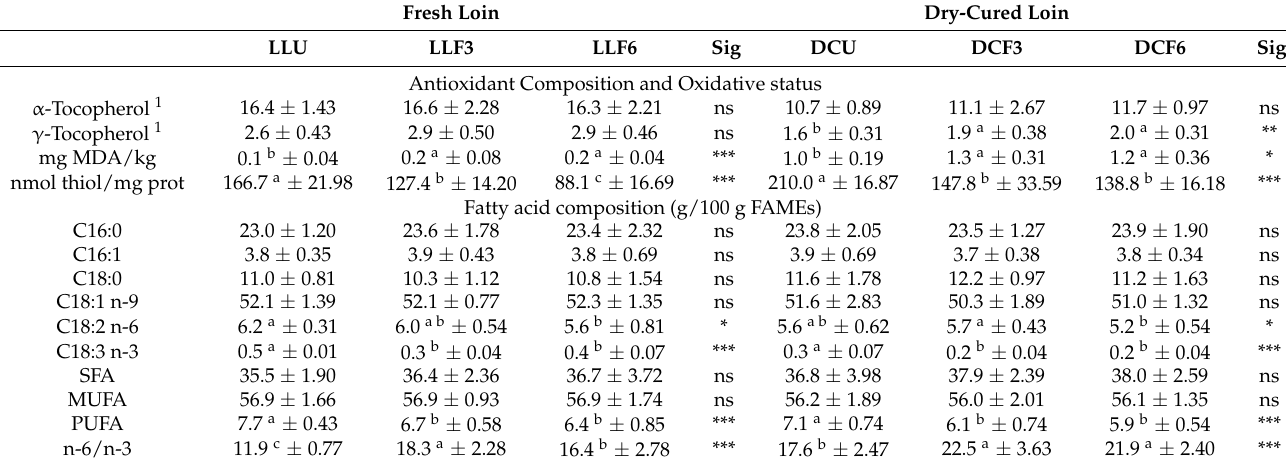
Values are expressed as means ± standard error of 15 samples/treatment. 1 Expressed as µ g of α - or γ -tocopherol/g moisture-free tissue. Effect: freezing time on LLU, LLF3 and LLF6 = unfrozen, and frozen during three- or six-months Longissimus lumborum muscle, respectively and pre-freezing cure time on DCU, DCF3 and DCFF6 = dry-cured loins from Longissimus thoracis muscle unfrozen and frozen during three and six months, respectively. FAMEs, fatty acid methyl esters; C16:0, palmitic acid; C16:1, palmitoleic acid; C18:0, stearic acid; C18:1